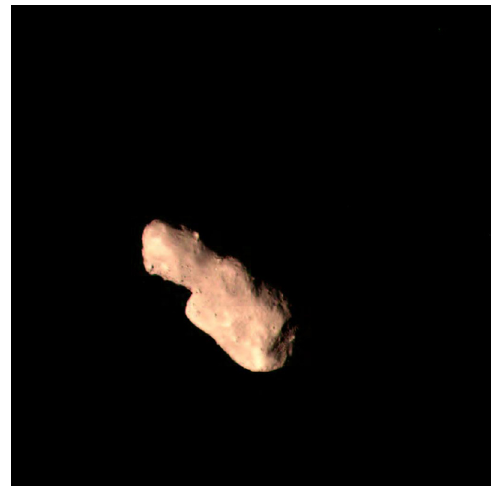
Figure 1: Image of Toutatis by Chang ’ e 2 engineering camera designed to monitor the state of the solar panel on December 13th,